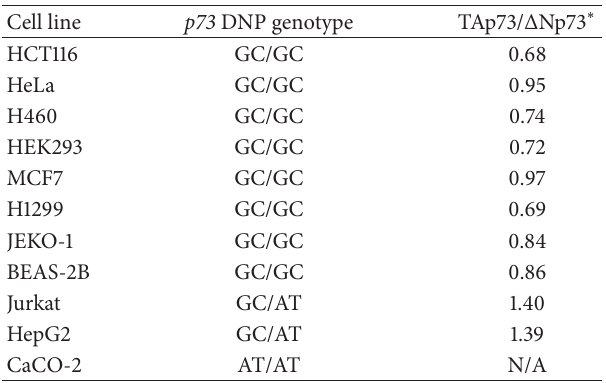
Table 3: p73 DNP genotypes and p73 isoform expression ratios for cancer cell